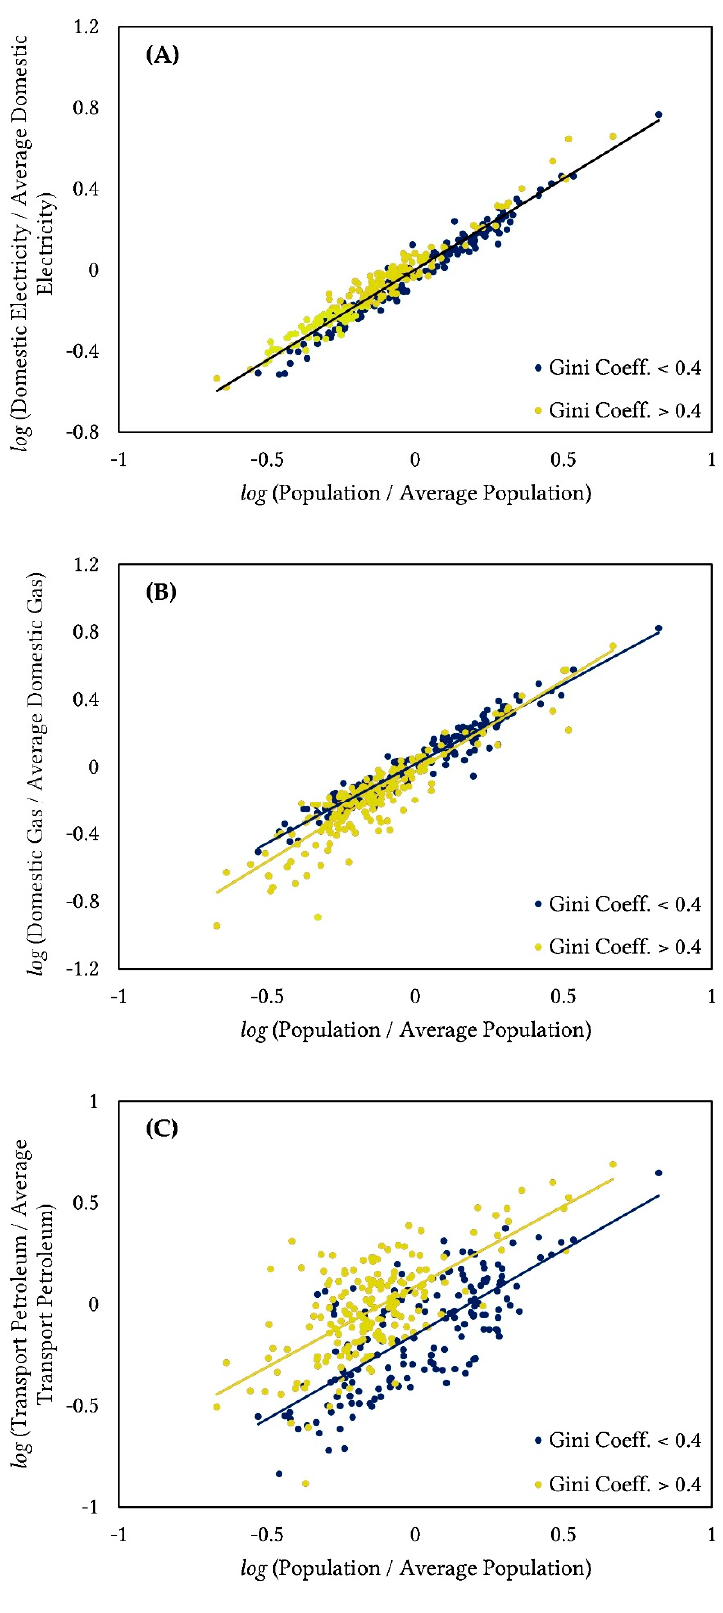
Figure 3. Log-log variations of average-normalized ( A ) domestic electricity; ( B ) domestic gas; and ( C ) road transport petroleum fuel with population (urban and rural LAUs have been denoted by blue and yellow, respectively).